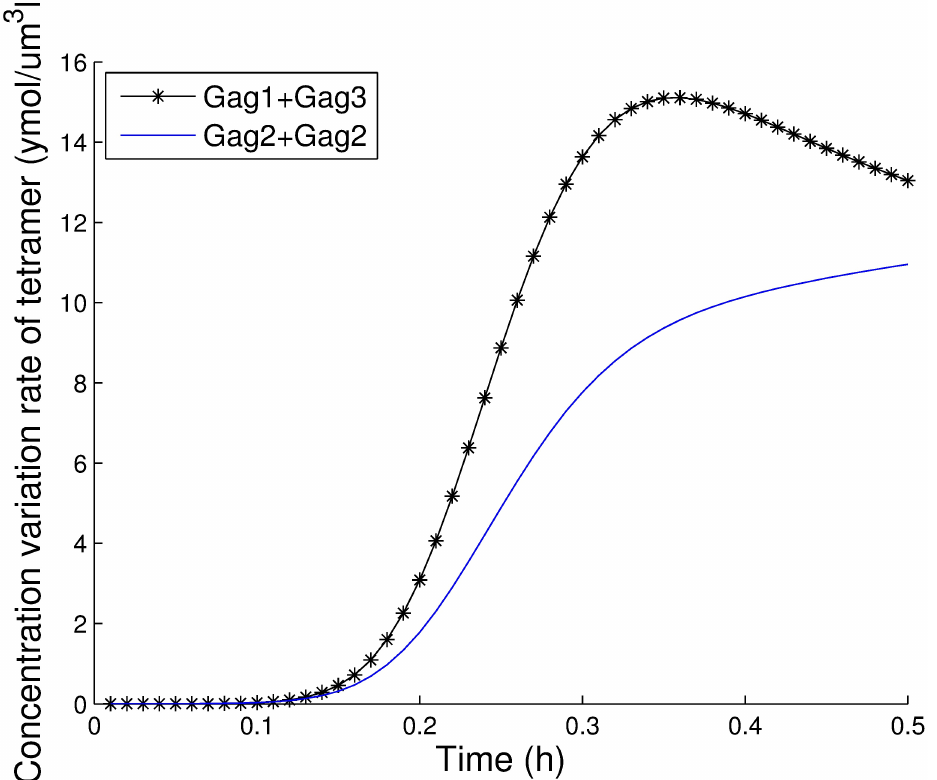
Fig 12. The contributions of two pathways to form tetramers.